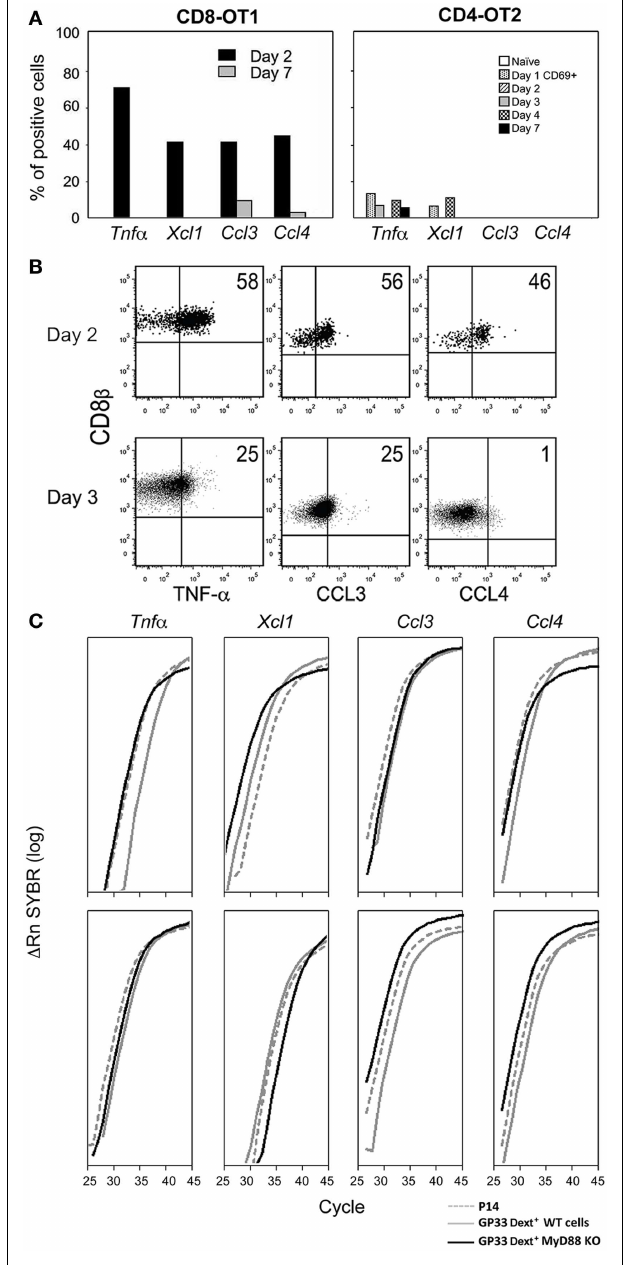
FIGURE 1 | Expression of inflammatory mediators by CD8T cells . (A,B) Mo CD90.2TCR-Tg cells were transferred to CD90.1 B6 mice, and immunized with LM-OVA expressing the OT1 and OT2 epitopes. At different time points after infection we determined: (A) The proportion of OT1 and OT2Tg cells expressing these mRNAs evaluated in 72 individual cells by single-cell RT-PCRs. (B) The ex vivo intracellular expression of pro-inflammatory proteins in Brefeldin A injected mice. Barriers to identify positive cells were based on the labeling of the same cell suspension with isotype control antibodies.The lack of suitable Abs prevented us from evaluating XCL1 expression. (C) Mo CD90.2 P14TCR-Tg cells were transferred to CD90.1 B6 mice. 24h later, these transferred mice, as well as My88 + and MyD88 − mice were immunized simultaneously with